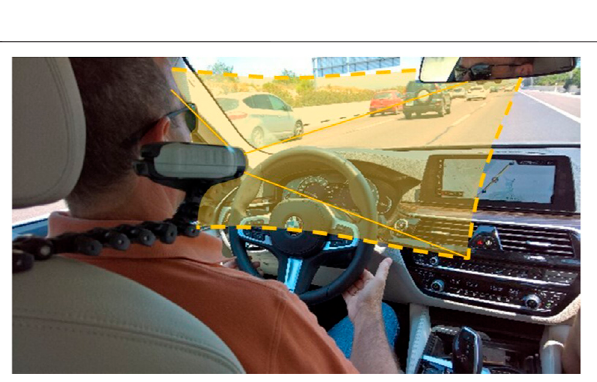
FIGURE 3 | Field of view of the video camera during data